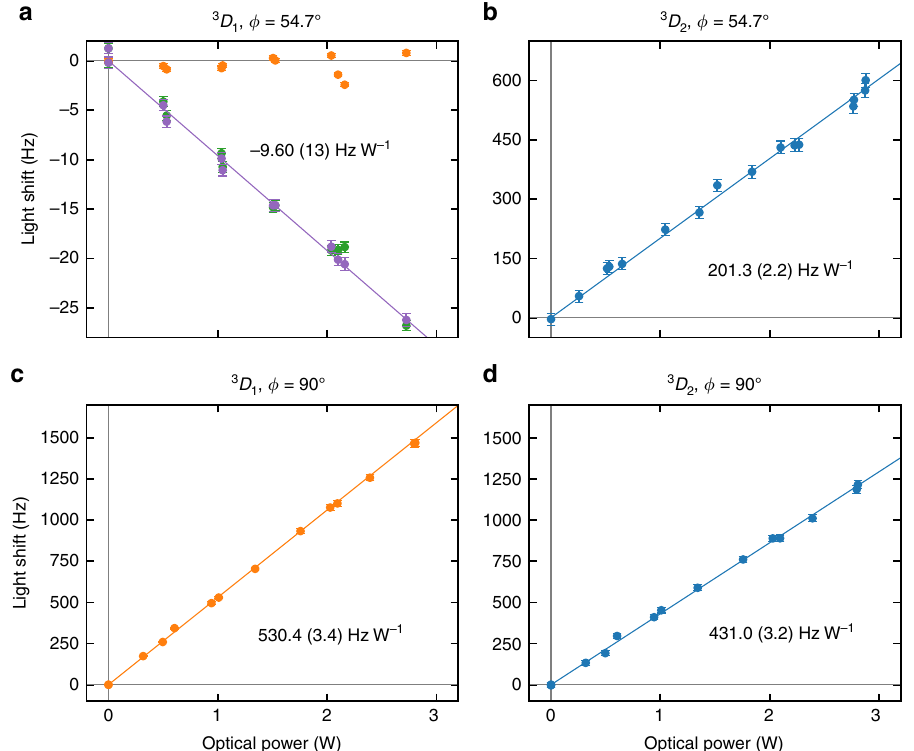
Fig. 3 Measured lights shifts. For the | 1 S 0 , F = 7, m F = 0 〉 ↔ | 3 D 1 , 7, 0 〉 (green points), | 1 S 0 , 7, 0 〉 ↔ | 3 D 2 , 9, 0 〉 (blue points) and | 3 D 1 , 7, 0 〉 ↔ | 3 D 1 , 6, 0 〉 (orange points) transitions, the light shifts are measured as a function of incident power on the ion. Purple points are derived from the green data set corrected for residual tensor shift (see text). Error bars are the rms sum of contributions from the statistical servo error and 1.5% optical power instability. Solid lines are single parameter linear fi ts obtained by χ 2 minimization 0.0